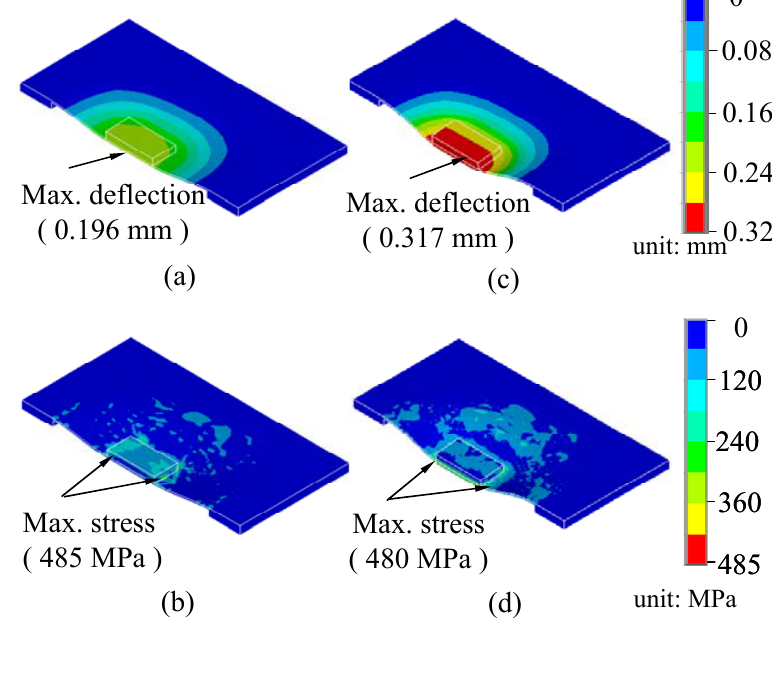
Figure 5. Simulation of the optimal pixel dimensions of the flexible electronics sensor at a constant force of 5 N. (a) Deflection and (b) stress distribution of a membrane with bumps, and (c) deflection and (d) stress distribution of a membrane with bumps and a resistance